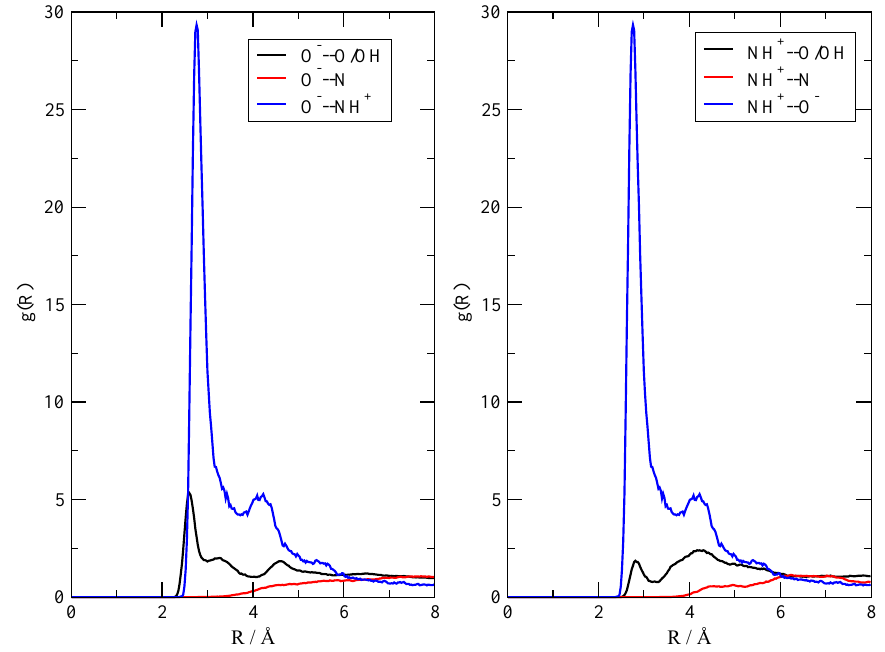
Figure 8. Radial distribution functions characterizing the immediate surroundings of two of the [TEAH + ][AcO – ] ionic pairs in the 20:20 simulation.